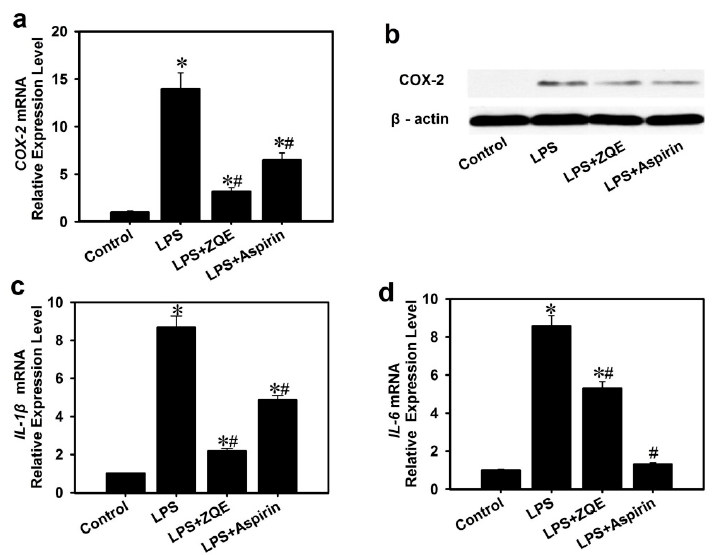
Figure 5. Effects of ZQE on LPS-induced COX-2, IL-1 β and IL-6 expression in RAW 264.7 macrophages.